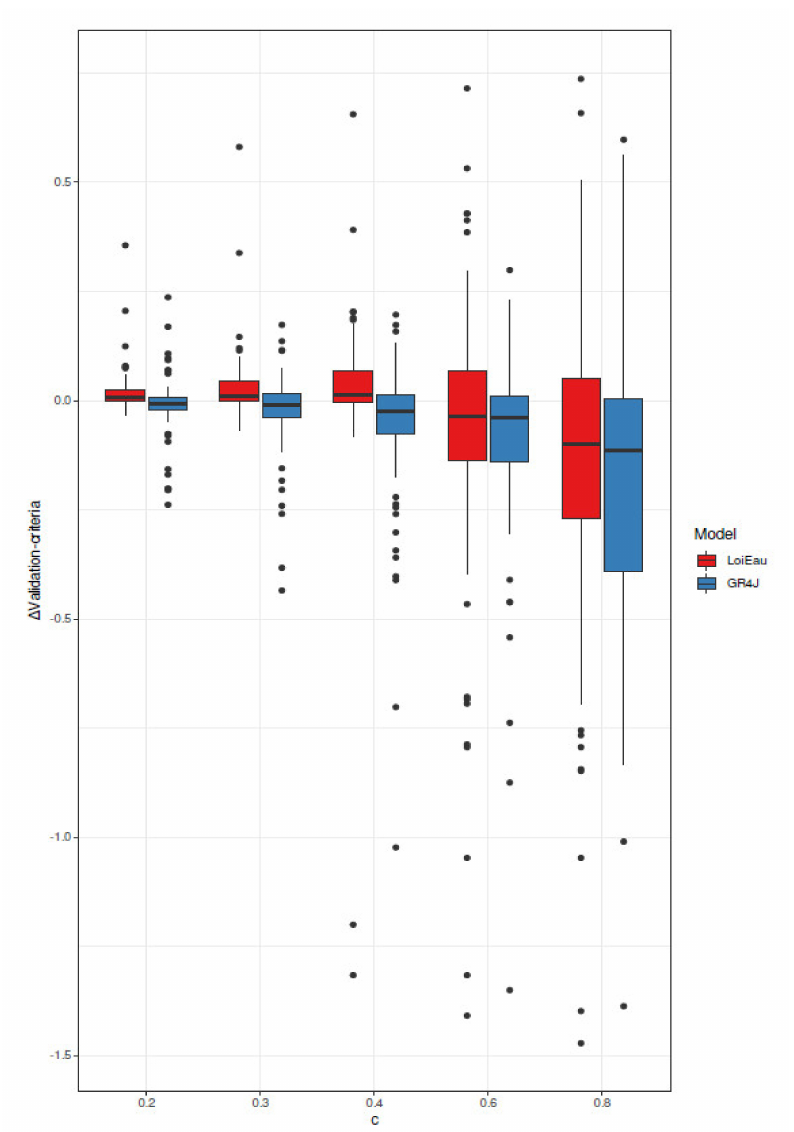
Figure 6. Distribution of the tested values of the weight “c” of the objective function FO (Q, H) for the calibration of the models GRLoiEau2J and